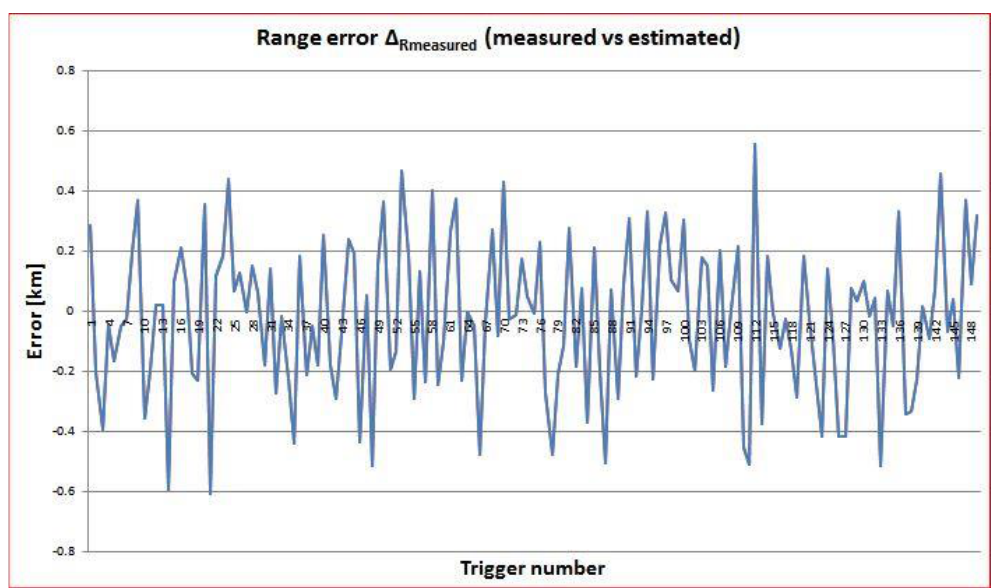
Figure 8. ( a ) Measured and filtered range values for COSMOS2932; ( b ) speed derived from measured and filtered Doppler values for COSMOS2932.